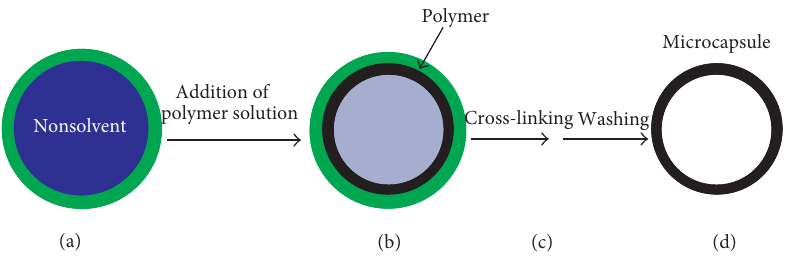
F 1: Schematic process of preparing the polymer